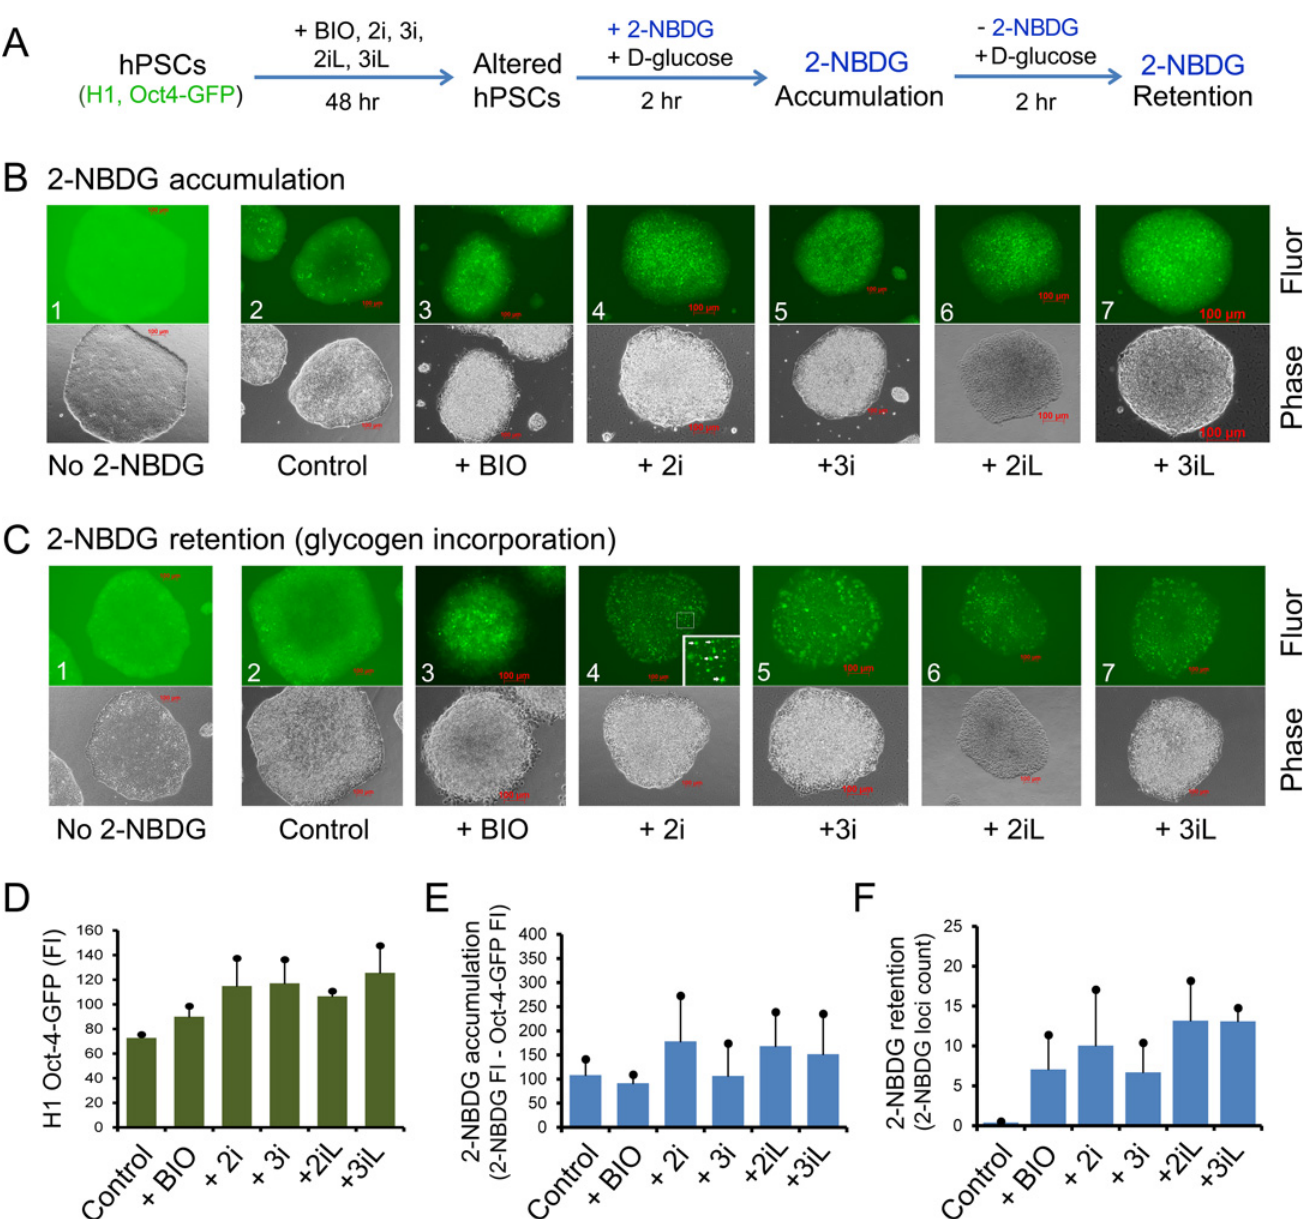
Fig 5. 2-NBDG accumulation and retention in H1 Oct4-EGFP under na ï ve hPSC growth conditions. ( A ) Schema of 2-NBDG accumulation and retention (glycogen labeling) experiments. ( B ) 2-hour 2-NBDG accumulation in the presence of 10 mM D-glucose. Upper panel: green fluorescence intensity (Fluor) images that include signals from both Oct4-EGFP and 2-NBDG. These images were obtained (immediately after replacing with fresh mTeSR1 medium) by non-saturated time-exposure guided by an autoexposure software (Zeiss Inc.). No 2-NBDG indicates fluorescence background images produced from Oct4-EGFP signal without the use of 2-NBDG. The fluorescence intensity was determined by the signal/noise ratio between cellular fluorescence (signal) and background (noise). The fluorescent background in the 2-NBDG control was due to non-saturated auto exposure using the Zeiss Axiovert imaging system. Lower panel: the corresponding phase images of the upper panel. Only brightness was adjusted in phase images (presented in both B and C) to enhance the image presentation in this figure. ( C ) 2-NBDG retention and glycogen labeling carried out in the presence of 10 mM D-glucose and absence of 2-NBDG. Upper panel: unique fluorescence loci (dots) were derived from 2-NBDG signals as indicated by arrows in the inset of Fig 5C4. Lower panel: the corresponding phase images of the upper panel. ( D ) Quantitative analysis of Oct4-EGFP signals without the addition of 2-NBDG. (E ) Quantitative analysis of 2-NBDG accumulation in Fig 5B. ( F ) Quantitative analysis of 2-NBDG retention and glycogen labeling by counting 2-NBDG loci as presented in Fig 5C. Columns represent mean fluorescence intensity measured from at least 4 random colonies and bar standard deviations. Abbreviations (depicted sequentially): BIO, 2 μ M GSK3i (BIO); 2i, 2 μ M BIO + 1 μ M MEKi; 3i, 2i + 1 μ M BMP4i; 2iL, 2i + 10 ng/mL LIF; 3iL, 3i + 10 ng/mL LIF; 2-NBDG, (2- (N-(7-nitrobenz-2-oxa-1,3-diazol-4-yl)amino)-2-deoxyglucose), a fluorescent glucose derivative, overlapping with EGFP signals. Scale bars represent 100 μ